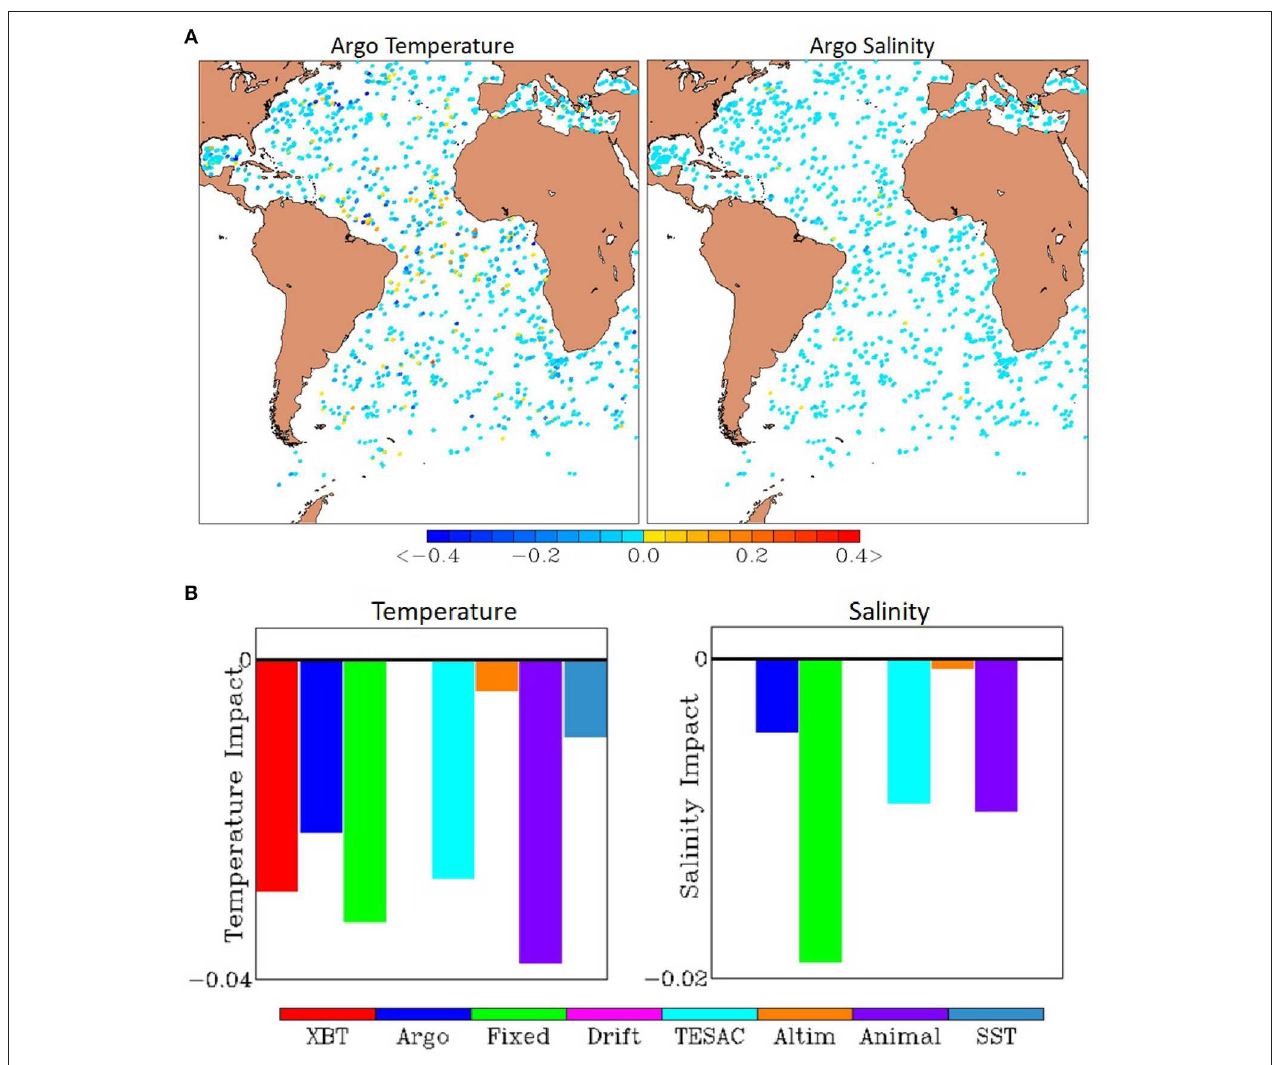
FIGURE 9 | FSOI evaluated for the ODAP system based on the global HYCOM. (A) Impacts of Argo profiles on reducing 48-h forecast error in the Atlantic basin from 30 July through 18 August 2018. Cool colors indicate beneficial impacts; warm colors indicate non-beneficial impacts. (B) Per observation impacts for temperature (left) and salinity (right) observing systems in the Atlantic for 30 July through 18 August, 2018. Temperature units are ◦ C and salinity units are